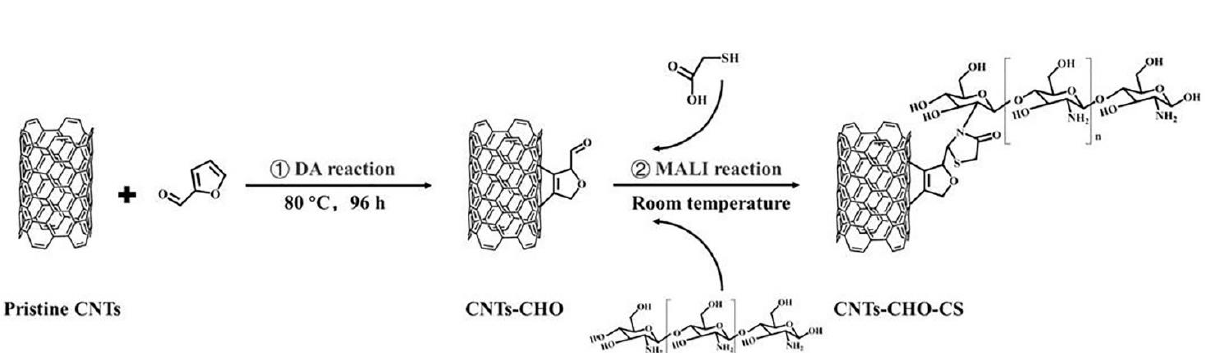
Figure 11. Functionalization of carbon nanotubes with chitosan based on MALI reaction. Adapted from ref. [101], copyright 2019, with permission from Elsevier.